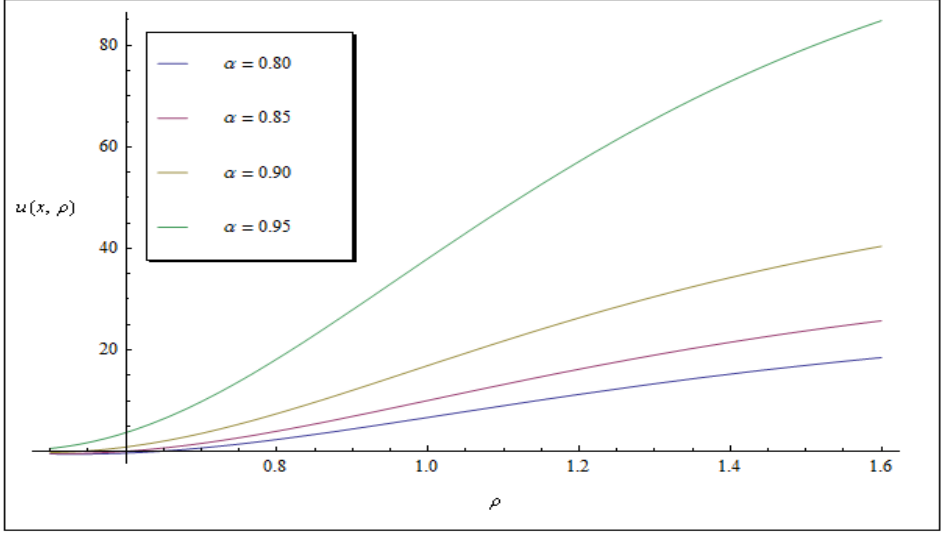
Figure 8. Solution of Equation (11) for various values of ϕ and ρ